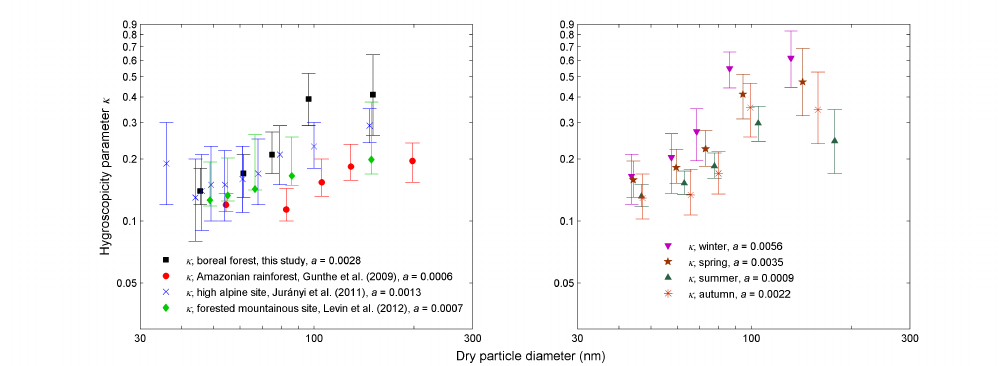
Fig. 6. Relationship between particle dry size (taken as D c ) and κ . Left panel shows the comparison among sites; right panel shows com- parison among seasons for Hyytiälä. Both panels show the median values with error bars being 25th and 75th percentiles (for Gunthe et al., 2009, percentiles estimated from the original publication). Legend entries also indicate the slope of the linear regression y = ax + b